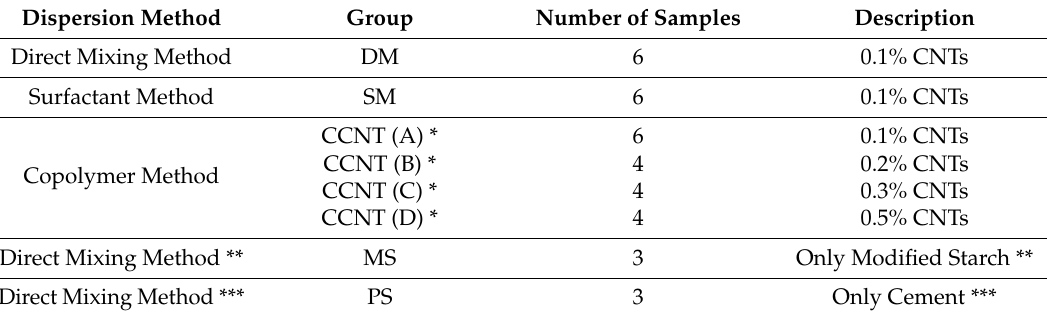
Table 1. Test Samples Used in this